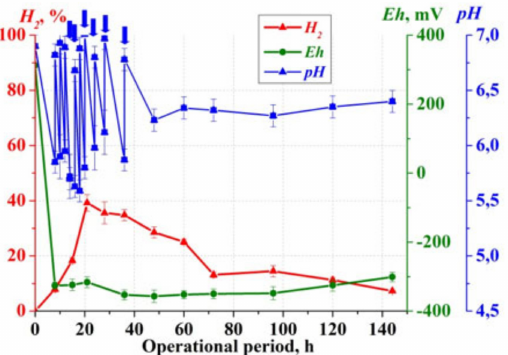
Figure 4. Effective fermentation of SFW using the granular microbial preparation (the arrows indicate the loading of pH